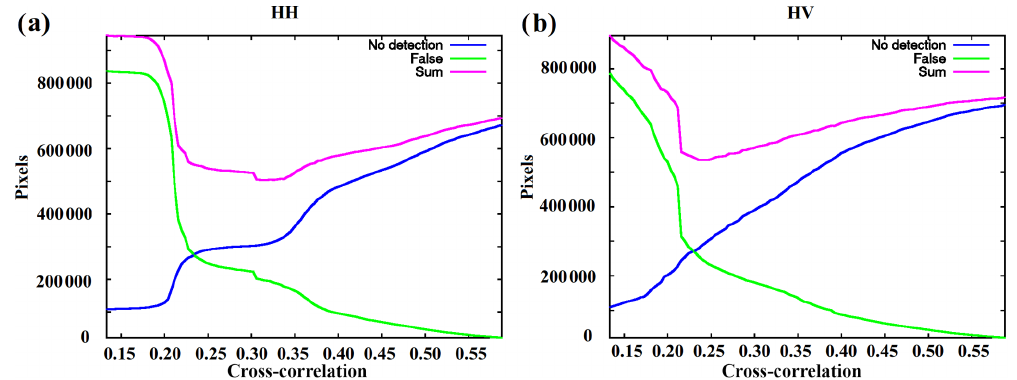
Figure 5. The total number of erroneously classified pixels as a function of the temporal cross-correlation average for HH channel SAR data (a) and for HV channel SAR data (b) . The optimal thresholds were defined as the minimum of the total error (“sum” curves according to the